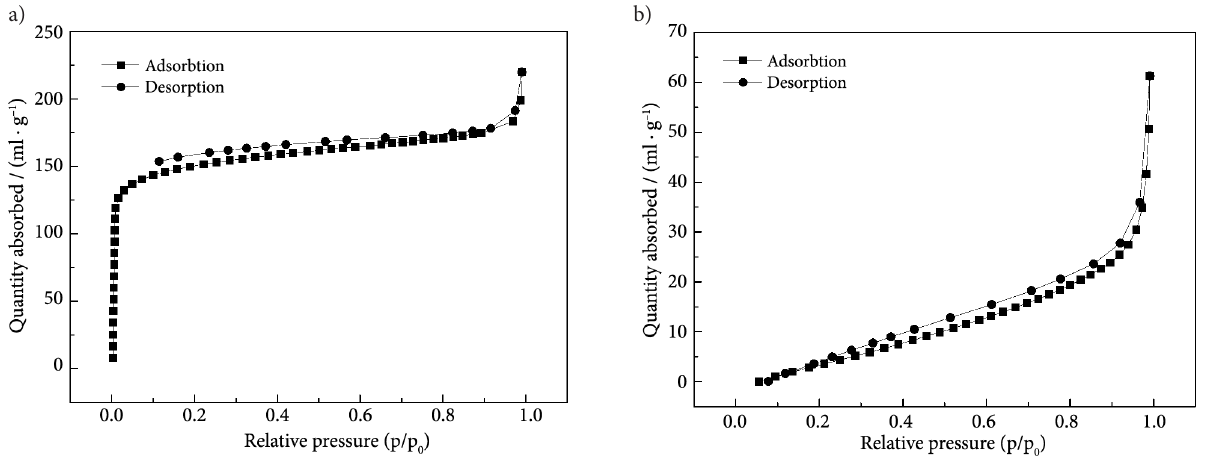
Figure 8. N 2 Absorption and desorption isotherm of activated carbon (a: ACmR2T350t70; b: ACmR2T350t70 after H 2 S